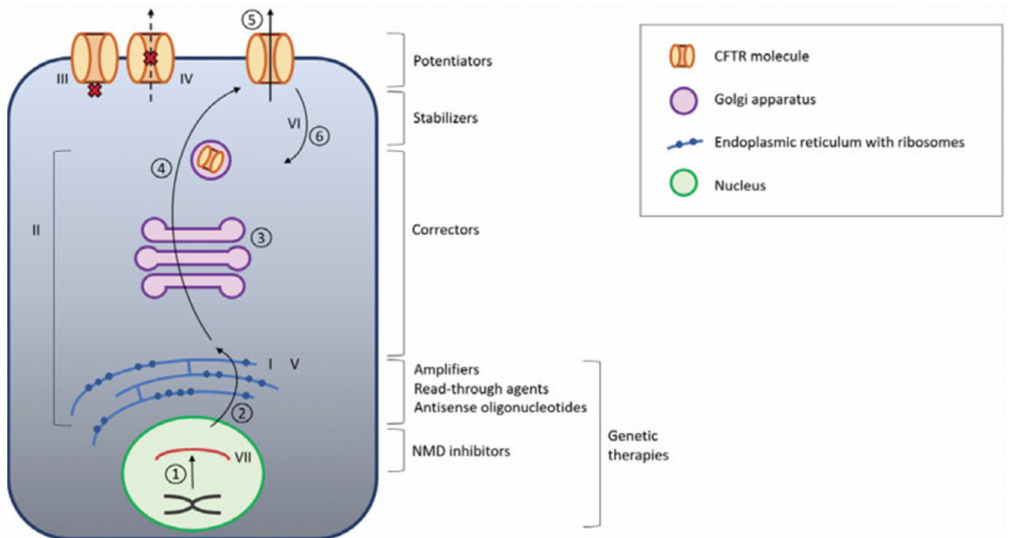
Figure 3. CFTR modulators. 1: transcription; 2: translation; 3: posttranslational modification; 4: protein trafficking; 5: surface expression of functional CFTR; 6: CFTR turnover. CFTR: cystic fibrosis transmembrane conductance regulator. NMD nonsense-mediated mRNA decay. The Roman numerals (I–VII) represent the different classes of CFTR mutations and the place where they originate, and therefore also the target of treatment. Adapted from Cuyx, De Boeck. Treating the Underlying CFTR defect in Patients with CF